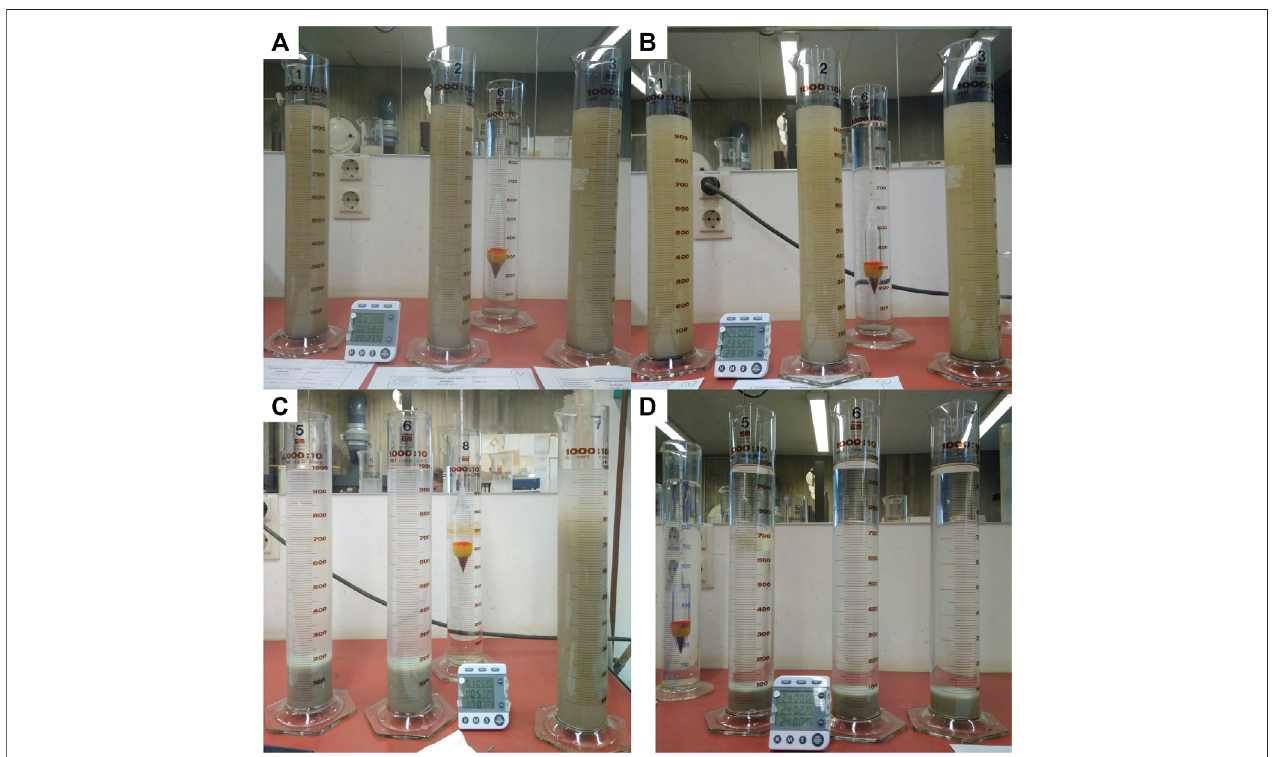
FIGURE8| Experimentalsetupforthehydrometeranalysistodeterminethegrainsizedistributionswiththreeidenticalprobesperruntoguaranteereproducibility. (A) montmorillonite clay in DI-water after 1 h 15 min, (B) same as (A) but after 24 h, (C) montmorillonite clay in salt water (35 PSU) after 1 h (cylinder 5 and 6) and 7 min (cylinder 7), and (D) same as (C) but after 24 h.